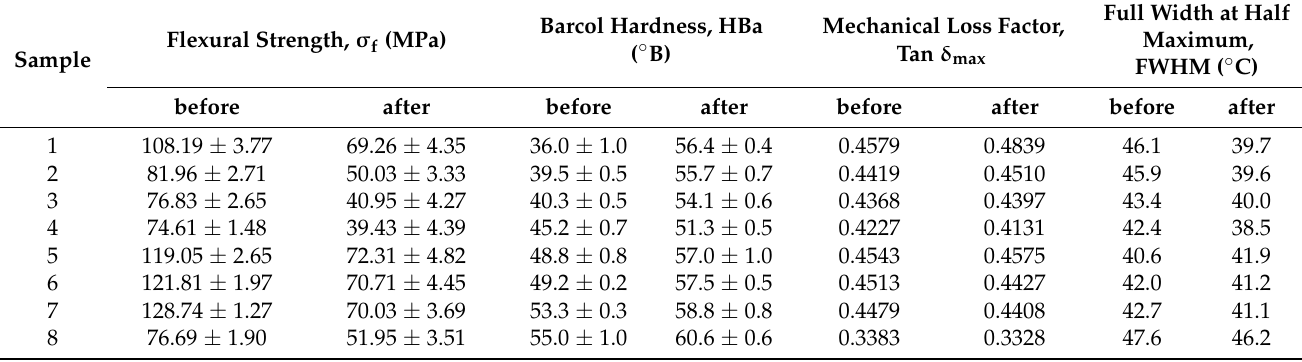
Table 2. Mechanical and thermomechanical data for the studied composite samples before and after the accelerated aging test.